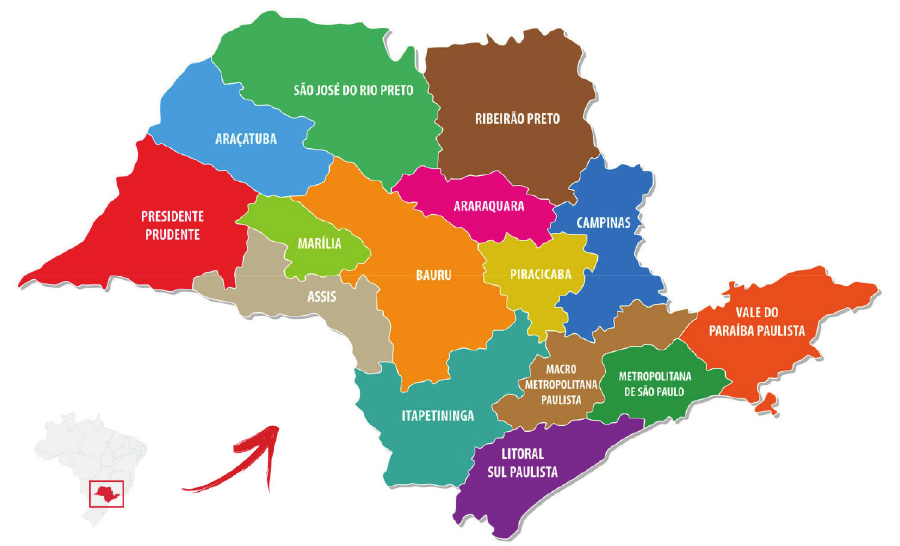
FIGURE 1 – Macroregions of São Paulo State, Brazil, where the dialysis water samples were collected for the study from 2010 to 2016.